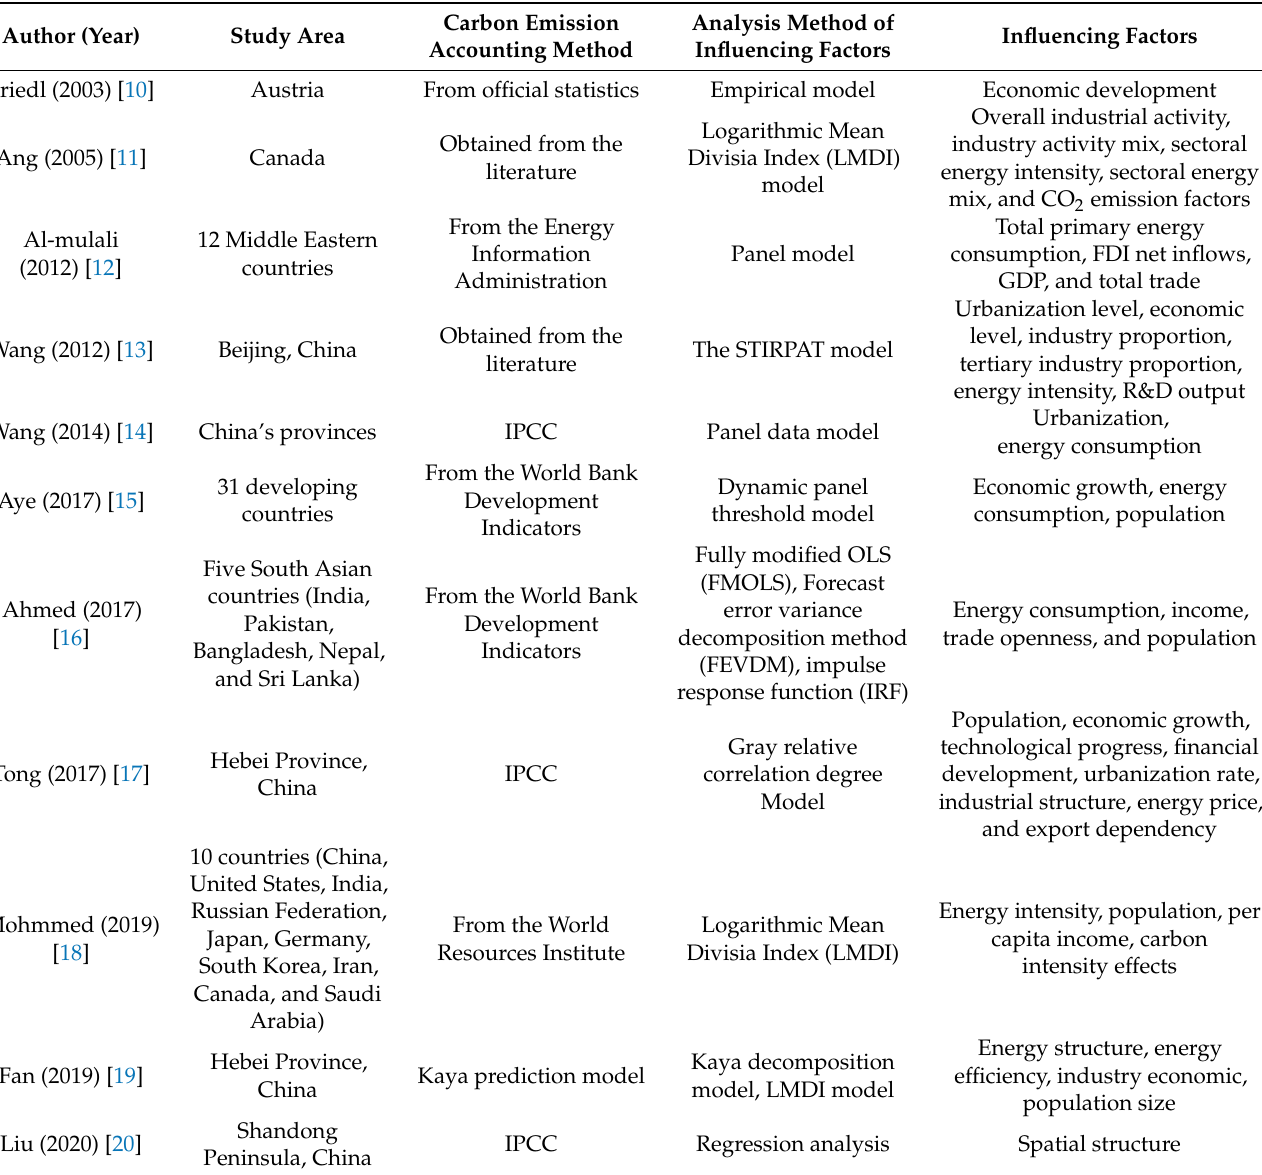
Table 1. Research on low carbon